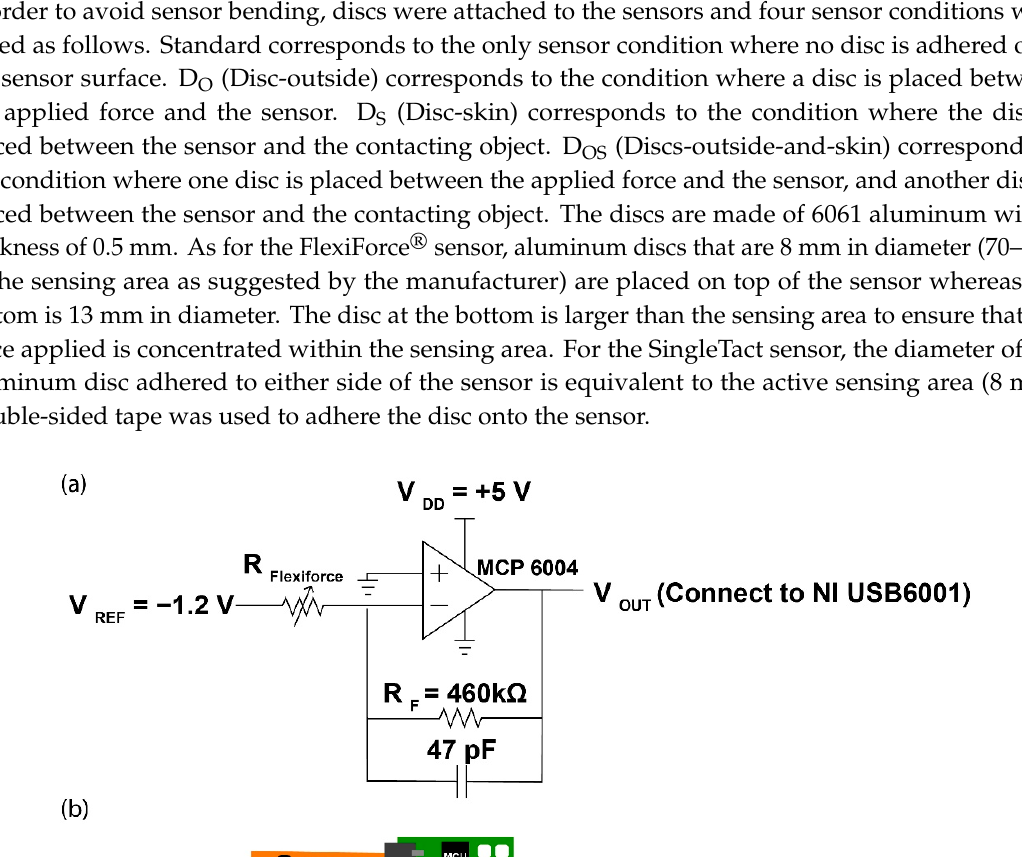
Table 1. Sensor specifications.